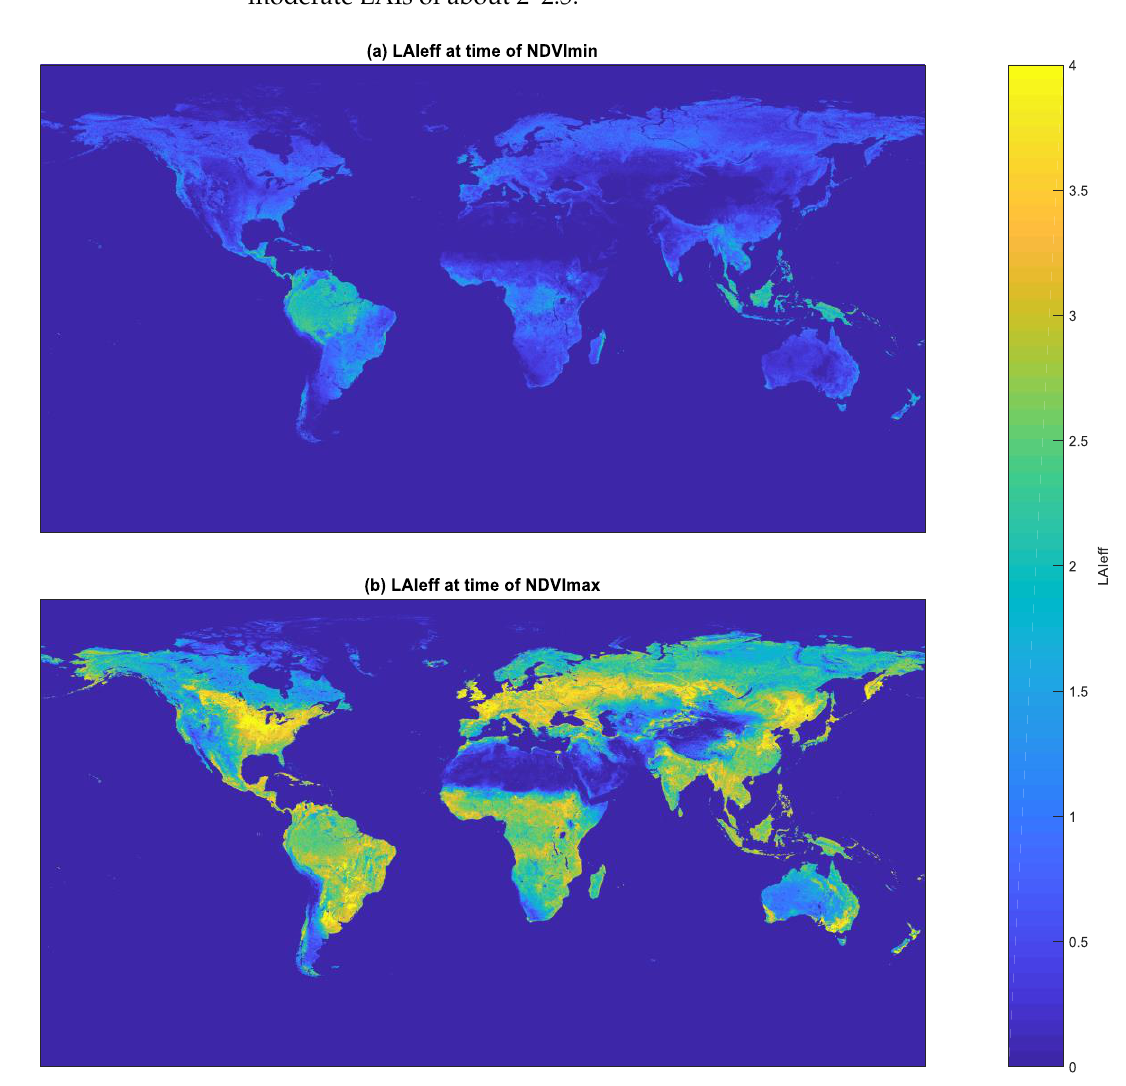
Figure 10. Estimated effective LAI from the DLUT applied to the red–NIR bands of the images of Figure 9.